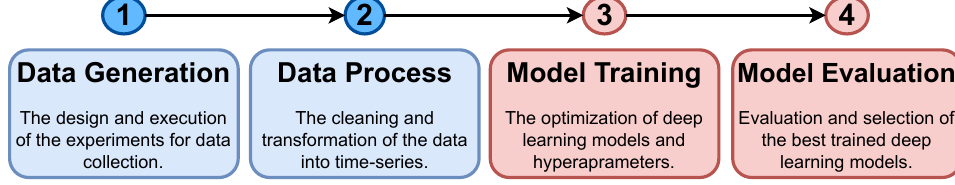
Figure 2. Overview of the steps of the followed method, including: Data Generation (see Section 5.1), Data Processing (see Section 5.2), Model Training (see Section 6), and Model Evaluation (see Section